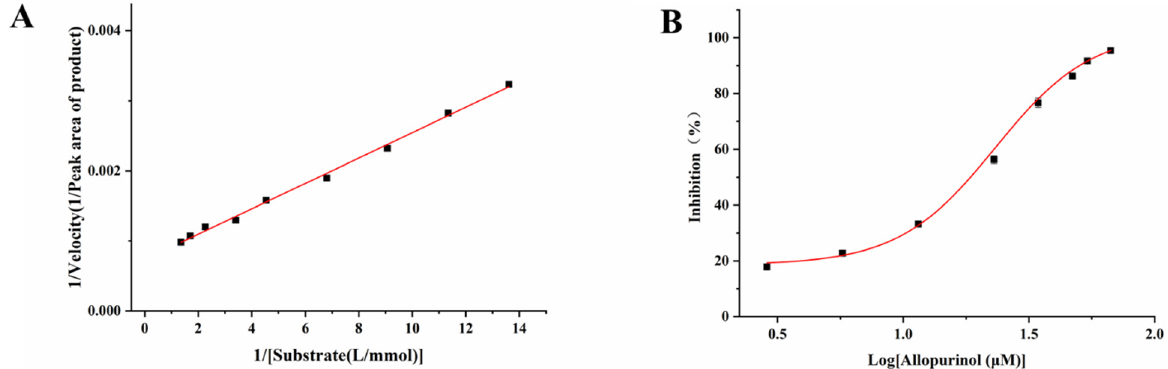
Figure 5. Double reciprocal plot at varied concentrations of substrate ranging from 0.07 to 0.7 μ M ( A ). The inhibition curve for allopurinol on PDA@HF-immobilized XOD ( B ).